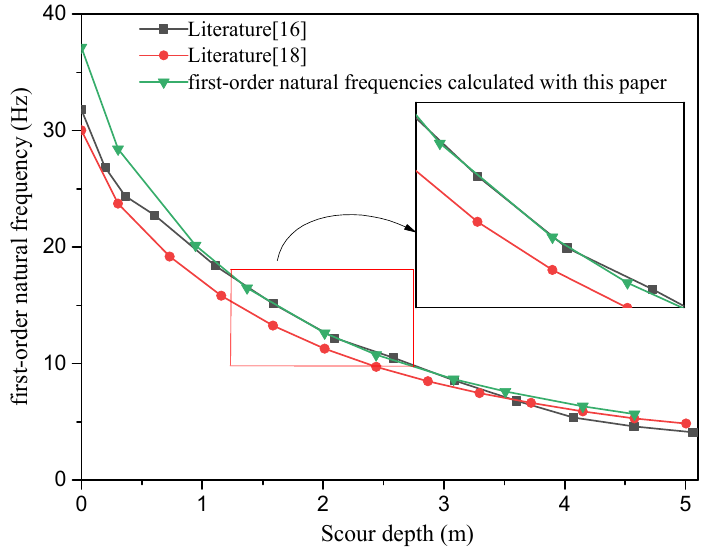
Figure 4. Comparison of the first-order natural frequencies calculated by the finite difference method with the measurement result by Prendergast et al. [16,18].